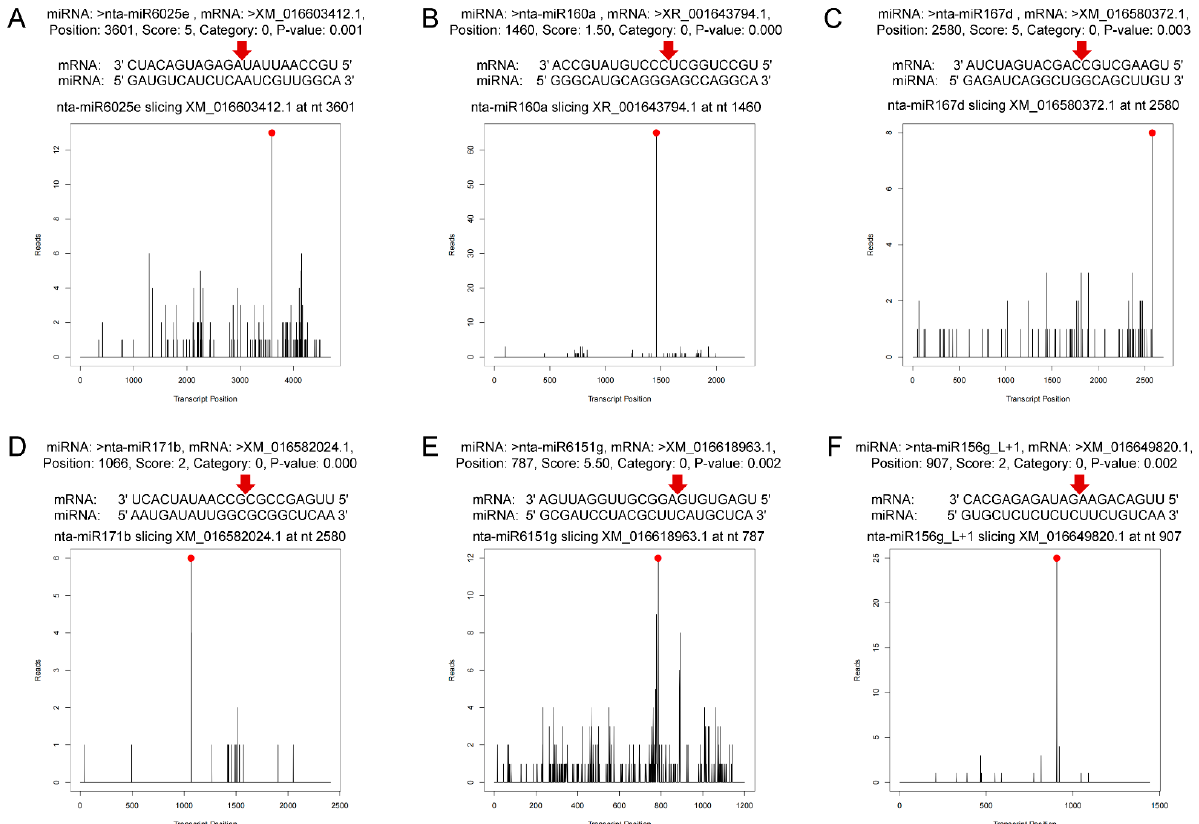
Figure 3. Target plots (t-plots) of miRNAs and their targets. The red dots indicate the most abundant peaks, and the red arrows indicate the cleavage sites. ( A ) miR6025e targeting uncharacterized protein of plant–pathogen interaction pathway. ( B ) miR160a targeting to auxin response factor 17. ( C ) miR167d targeting auxin response factor 6-like isoform X3. ( D ) miR171b targeting scarecrow-like protein 6 isoform X1. ( E ) miR6151g targeting uncharacterized protein related to nucleic acid binding and zinc ion binding. ( F ) miR156g_L+1 targeting squamosa promoter-binding-like protein 9.